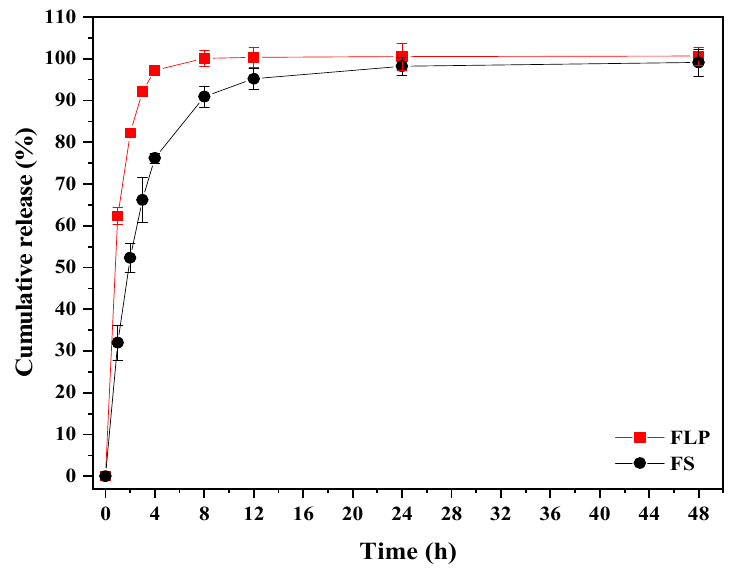
Figure 6. The cumulative release of FN from FLP and FS.